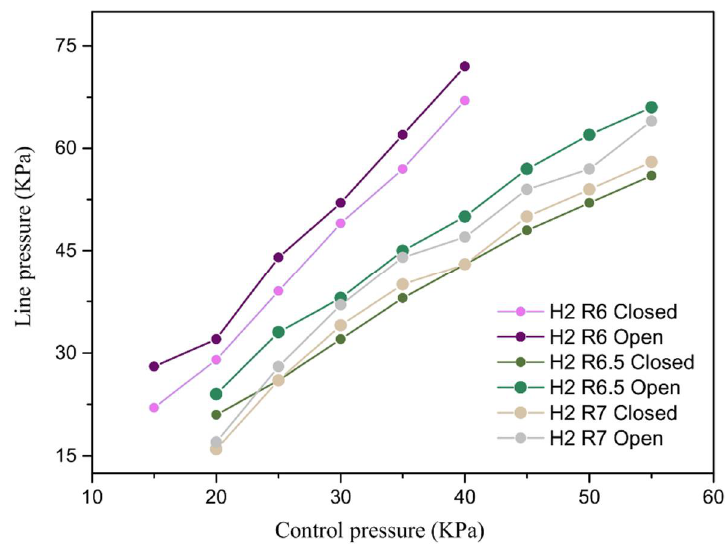
Figure 10. The relationship between driving pressure and line pressure for three types of flexible valves .